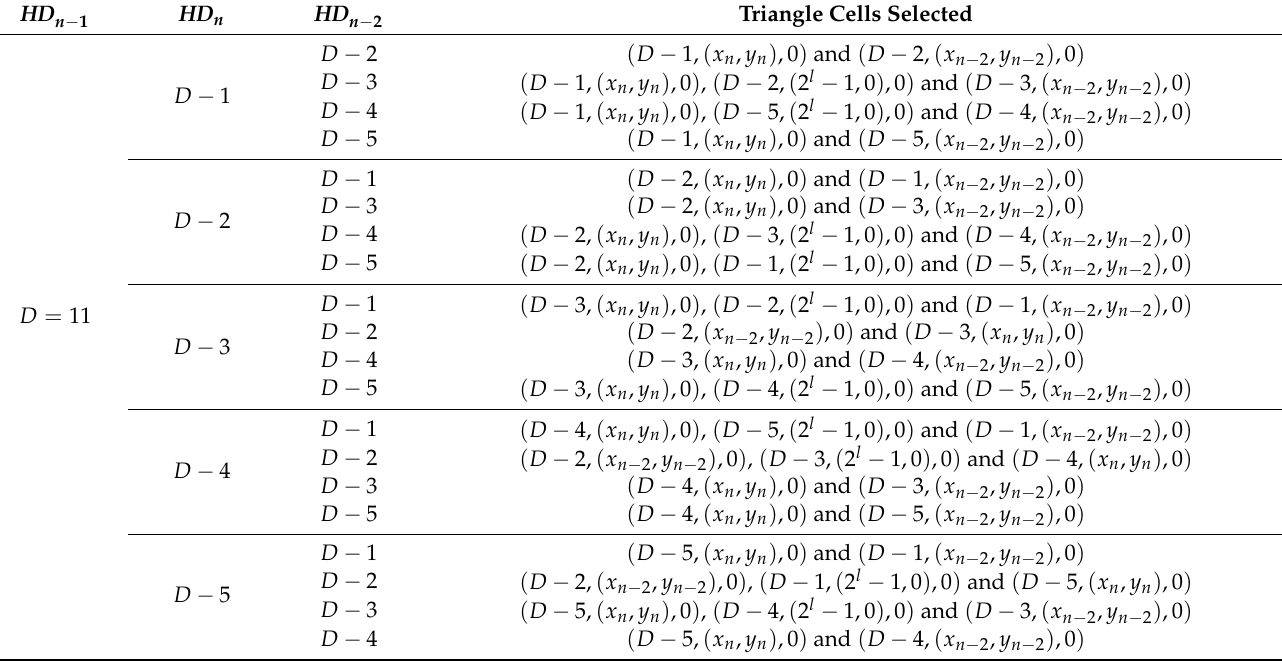
Table 14. Htotcode rule of the ( n − 1)th hexagon cell E 2